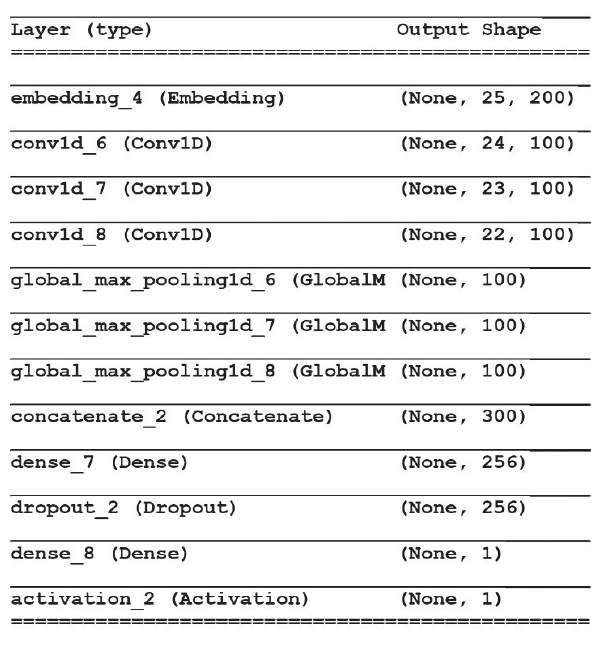
Figure 4 . Architecture of Convolutional Neural Network.